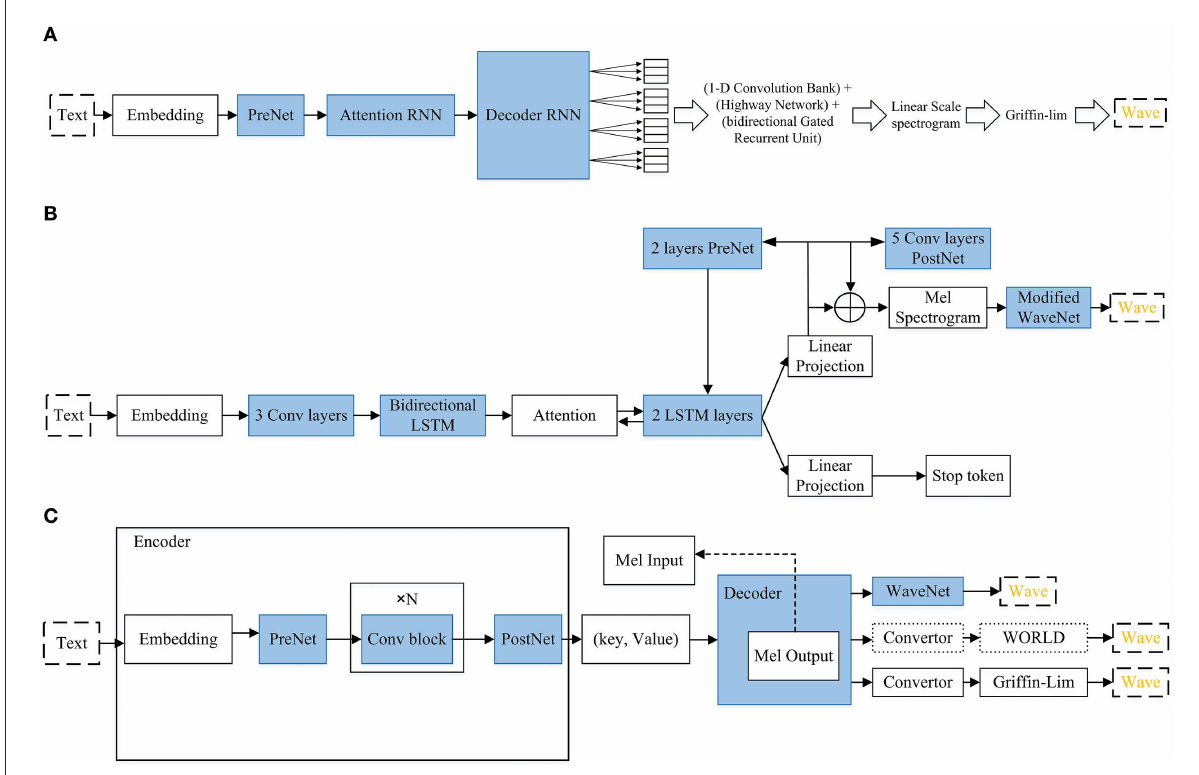
FIGURE7 (A) Tacotron. The model takes input characters, then goes to some RNN based networks as well as a 1-D convolution bank + highway network + bidirectional GRU. Then, it gives the corresponding raw spectrogram as output, that is fed to the Griffin-Lim reconstruction algorithm